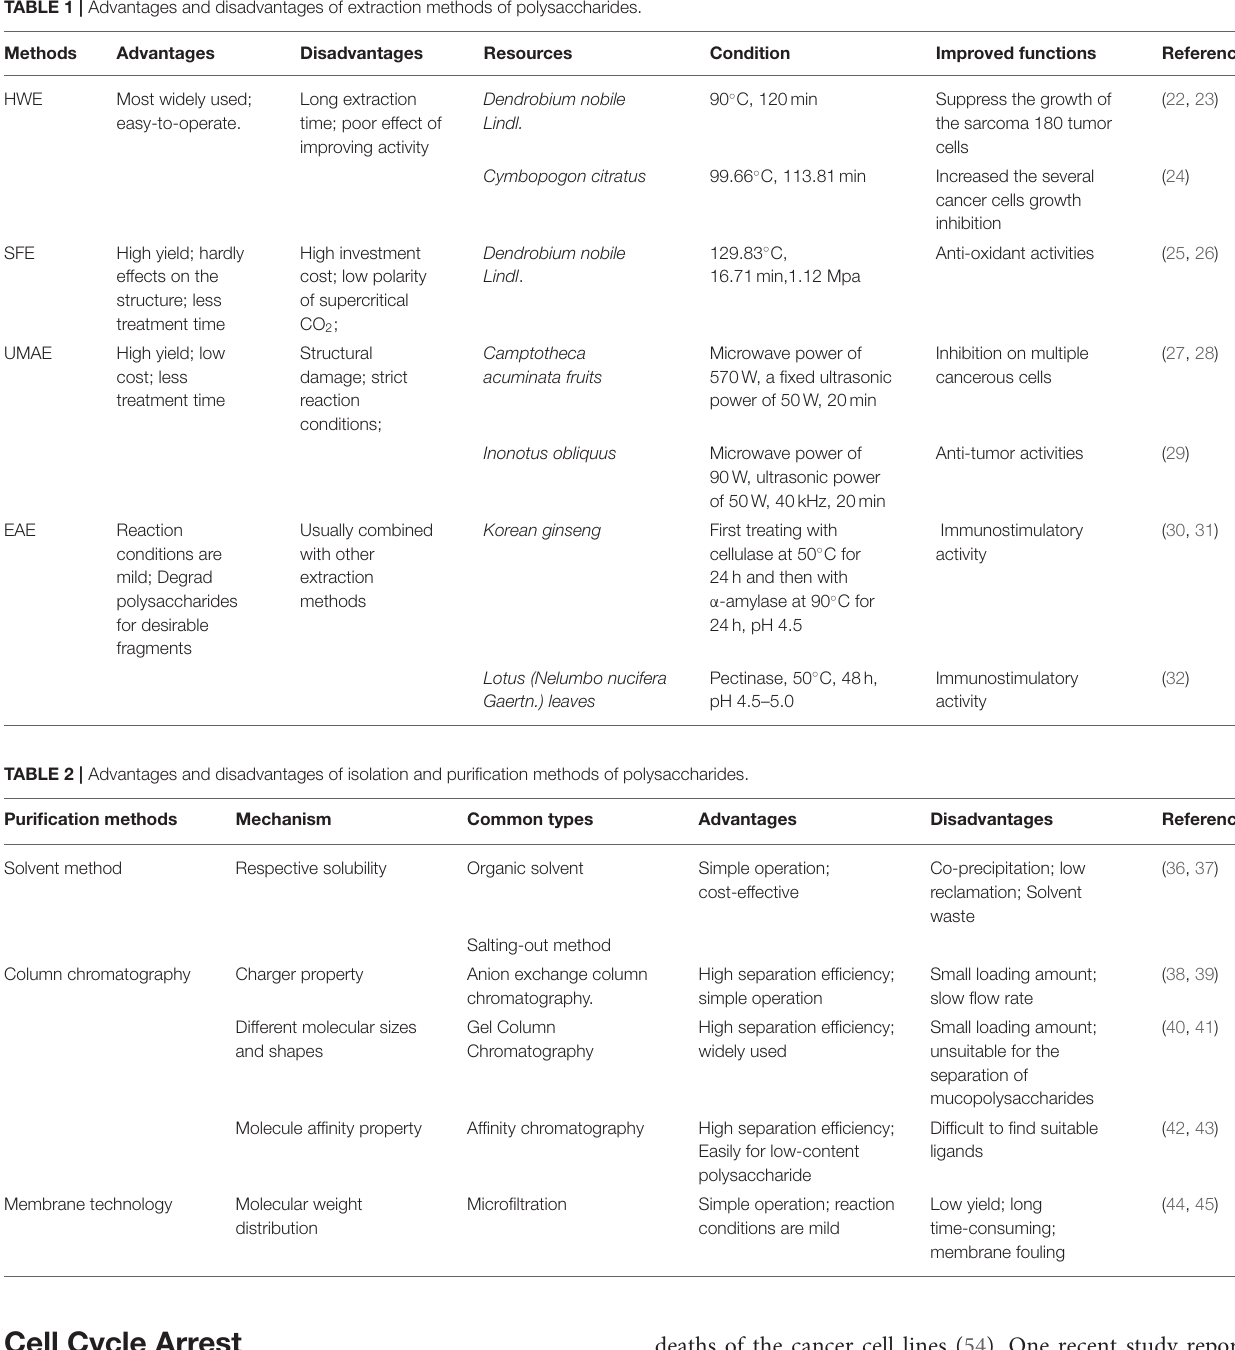
TABLE 1 | Advantages and disadvantages of extraction methods of polysaccharides.